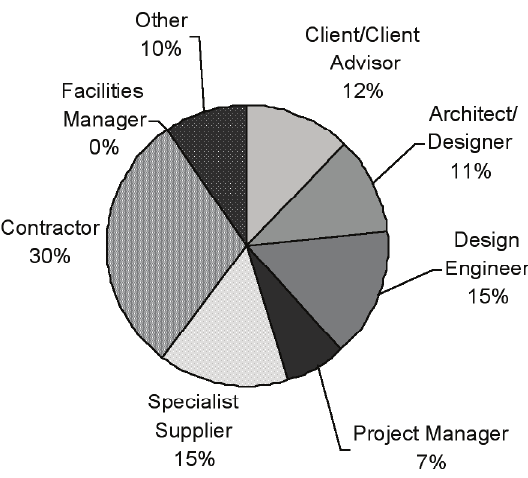
Figure 2: Chart illustrating the distribution of survey replies according to respondent’s roles